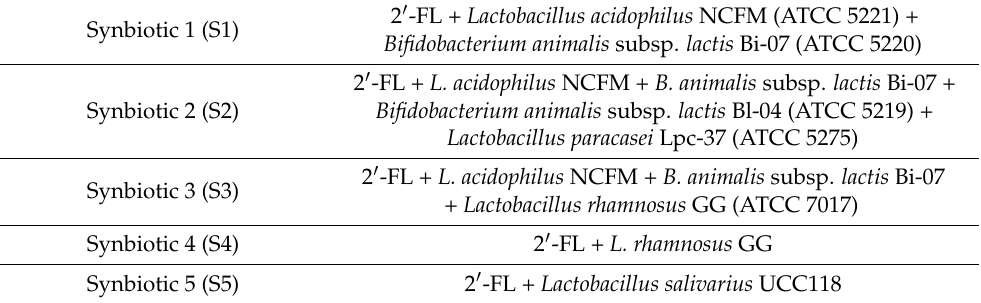
Table 1. Potential Synbiotic Combinations Evaluated In